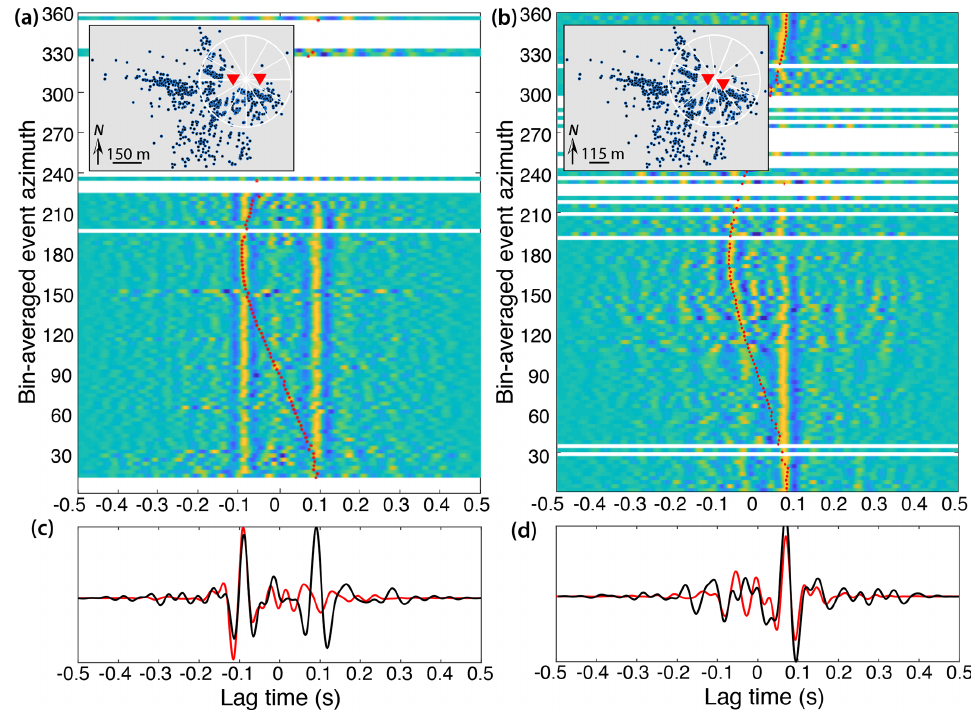
Figure 10. (a, b) Cross-correlation functions obtained at two station pairs from each source and plotted as a function of event azimuth relative to the station path, for a time window in the coda part. Rayleigh wave arrival times of correlation functions obtained for a time window which encompasses ballistic waves of icequake records are plotted in red dots. Stations, station separation, and source geometry are plotted in the inset maps. (c, d) Stack of the correlation functions obtained from icequake ballistic waves (red) and coda